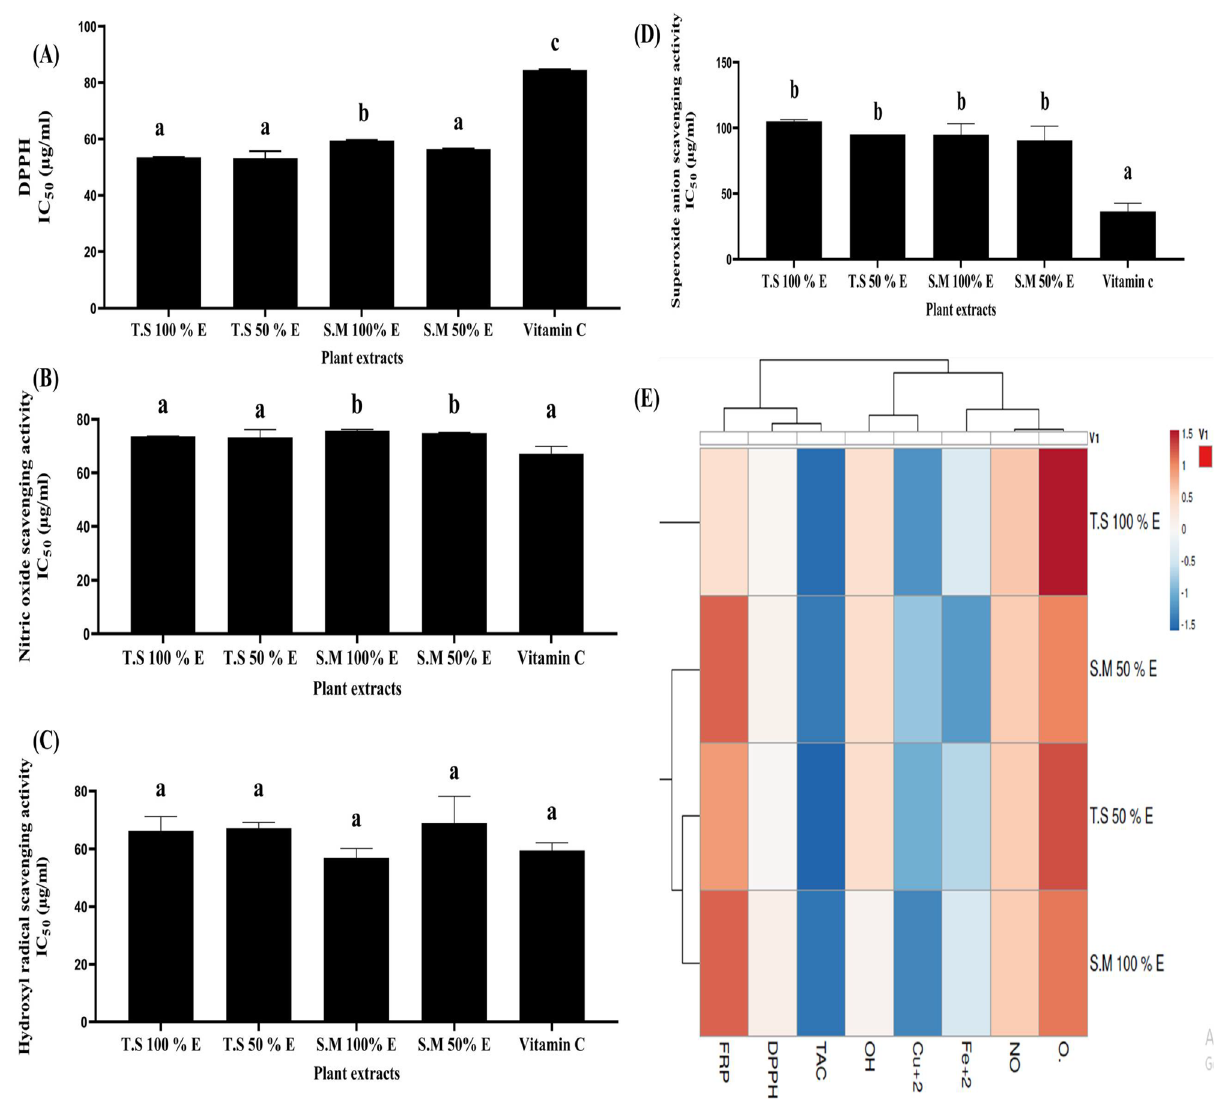
Figure 2. The radical scavenging activity of each plant extract in the term of IC 50 (µg/mL) with illustrative heat map distribution. ( A ): DPPH scavenging activity (IC 50 : µg/mL), ( B ) NO scavenging activity (IC 50 : µg/mL), ( C ) OH scavenging activity (IC 50 : µg/mL), and ( D ) Superoxide anion scavenging activity (IC 50 : µg/mL). All data are expressed as mean ± SEM. Different letters are significantly different at p ≤ 0.05. ( E ) Heat map distribution of in vitro antioxidant activities of the studied extracts. The color distributed from white (low level antioxidant activity or content) to blue (high level anti-oxidant activity or